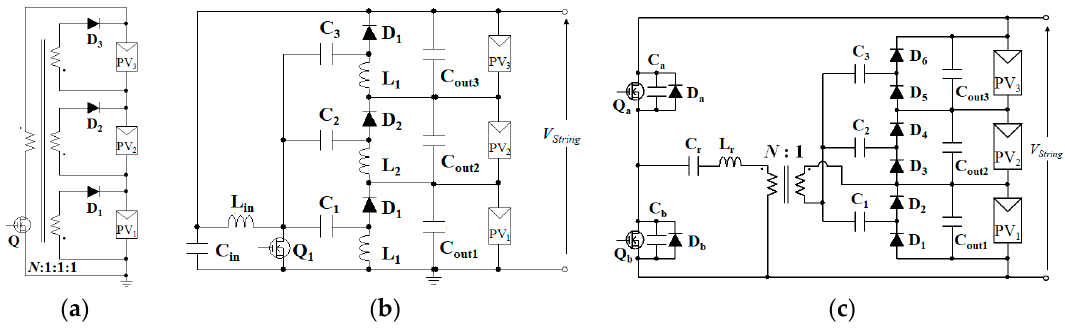
Figure 5. String-to-module DPP converters: ( a ) multi-winding flyback converter [21], ( b ) multi-stacked buck-boost converter [22,23], ( c ) series resonant voltage multiplier [24].